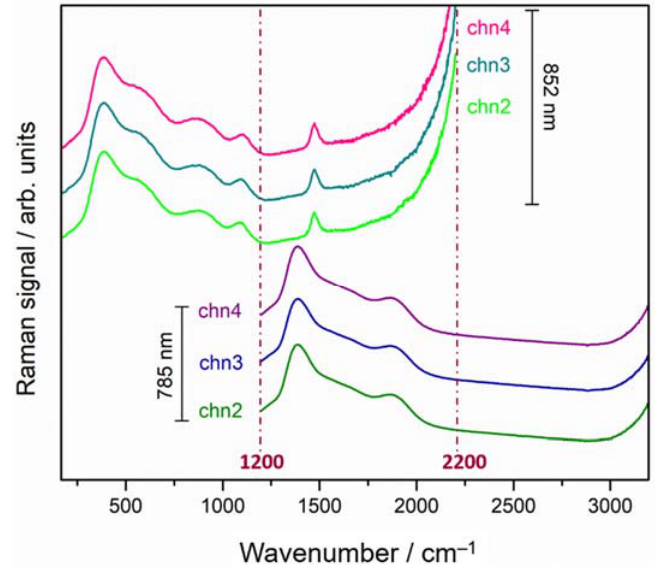
Figure 4. Three sequentially shifted Raman spectra acquired on the glass vials for each of the two temperature-controlled diode laser excitations (top)—852 nm (chn2–4) 170 to 2200 cm − 1 and (bottom) —785 nm (chn2–4) 1200 to 3200 cm − 1 (ch stands for the sequentially shifted channels as labeled in the measurement output); the vertical dashed lines define the overlapped spectral region (1200–2200 cm − 1 ).